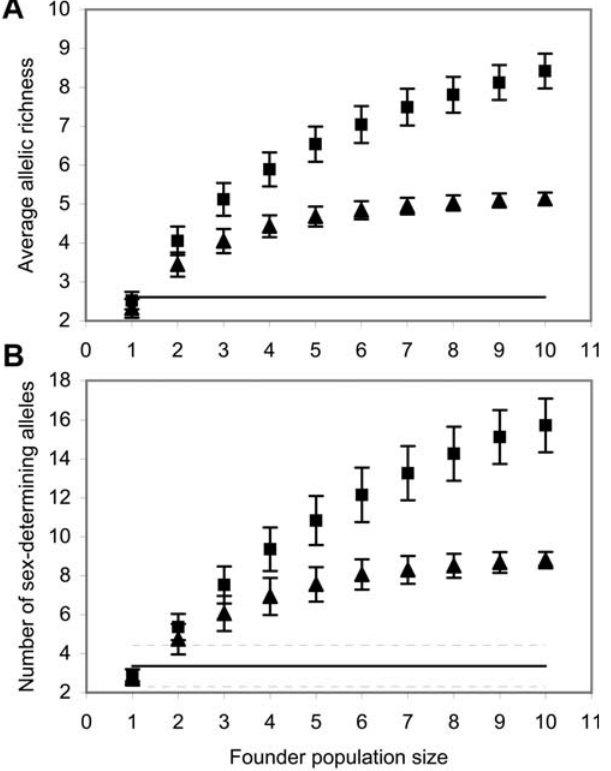
Figure 1. The allelic richness observed in introduced L.leucozonium populations, at both microsatellite loci and the sex-determination locus, is best explained by the introduction of a single founder. (A) The allelic richness observed in NA (solid line), and that estimated for founder populations derived from the French population (squares) or a source population with 50% less allelic richness (triangles). (B) The observed number of sex-determination alleles in NA (solid line) and those estimated for founder populations derived from a source population with 20 (squares) or 9 (triangles) sex-determining alleles– the range expected in natural hymenopteran populations. Dashed lines and error bars indicate standard deviation.